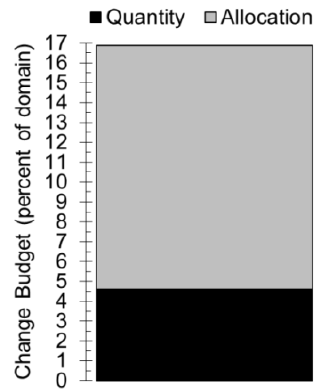
Figure 2. Total change separated into quantity and allocation.